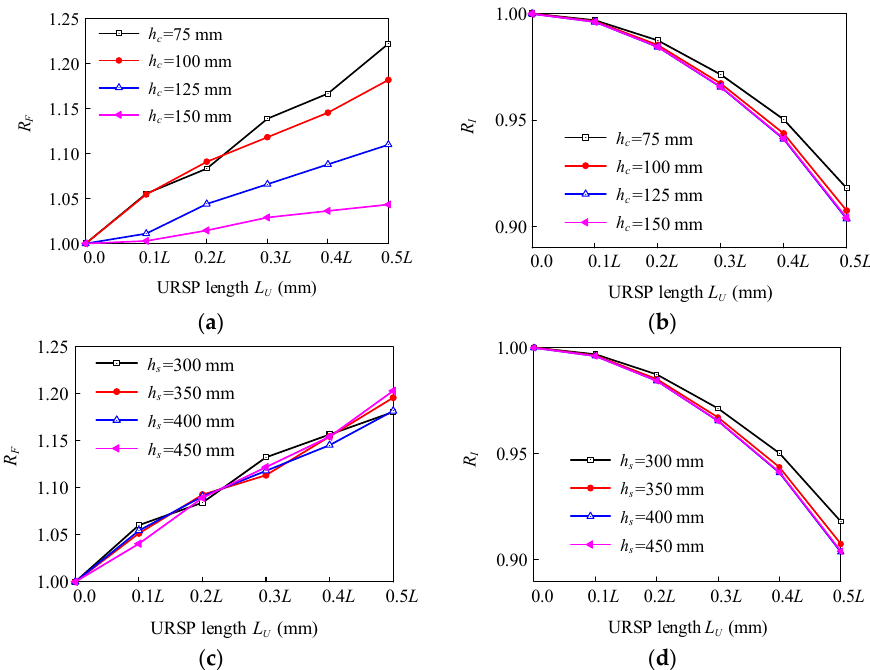
Figure 19. Results with different URSP lengths. ( a ) R F with different h c ; ( b ) R I with different h c ; ( c ) R F with different h s ; ( d ) R I with different h s .